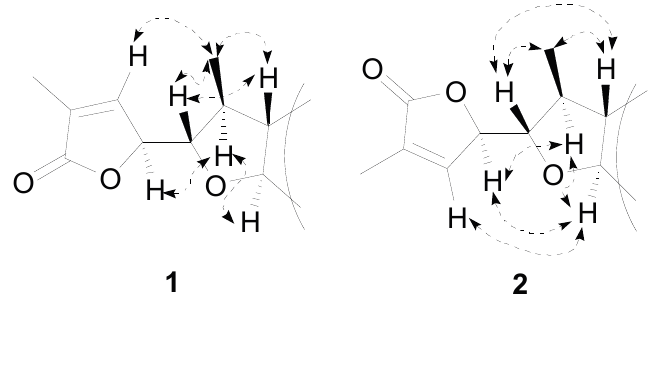
Figure 2. Key NOE correlations of compounds 1 and 2